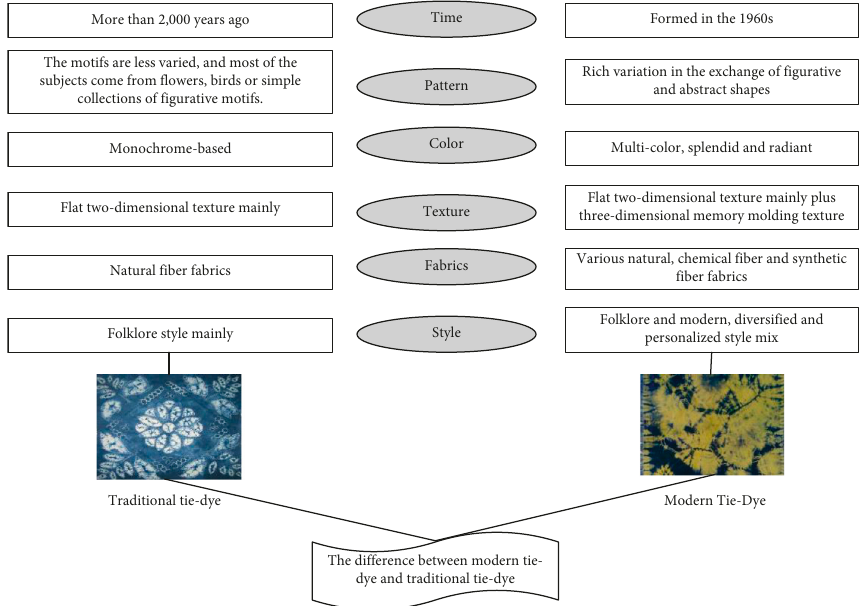
Figure 2: Comparison of modern tie-dye and traditional